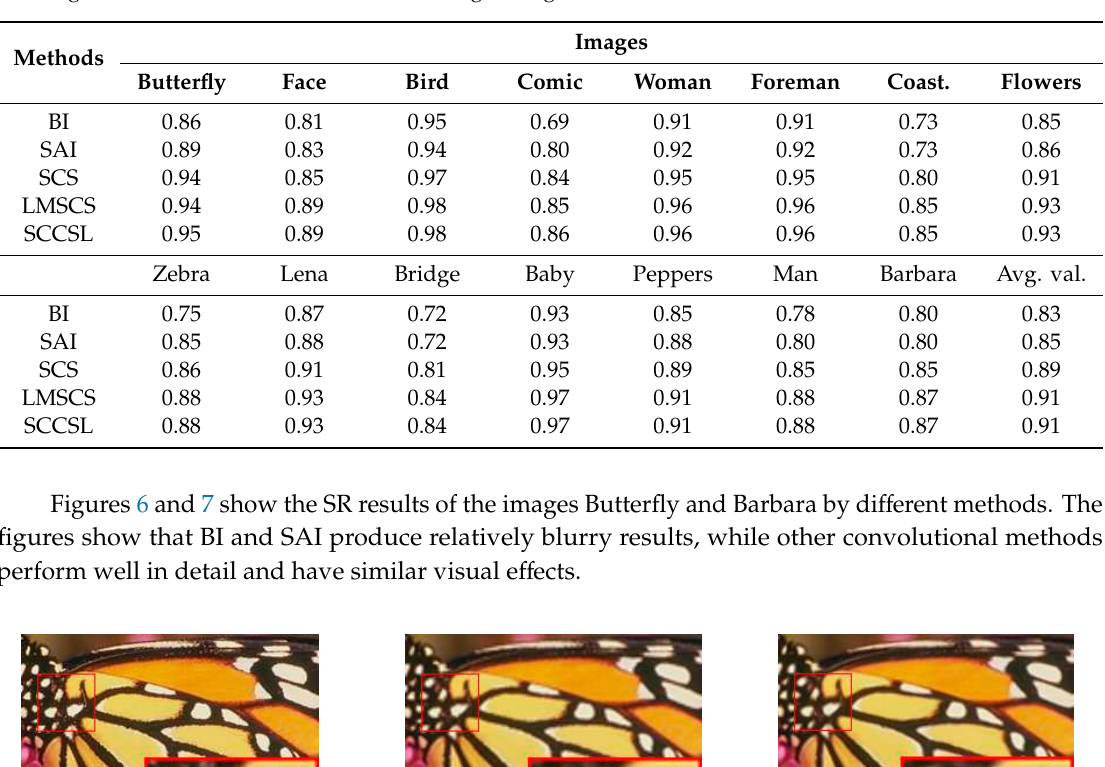
Table 2. The SSIM results of the 15 images by di ff erent methods, and bold font indicates that the algorithm has the best SSIM value on a single image.